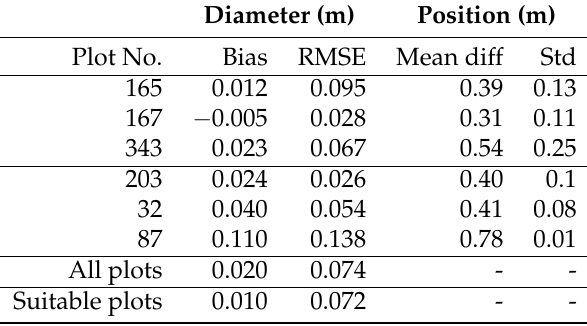
Table 3. Bias and RMSE of diameter estimation at the plot level for all (correct + incorrect) estimated trees; the mean difference (mean diff) of stem positions with the standard deviation (std) at the plot